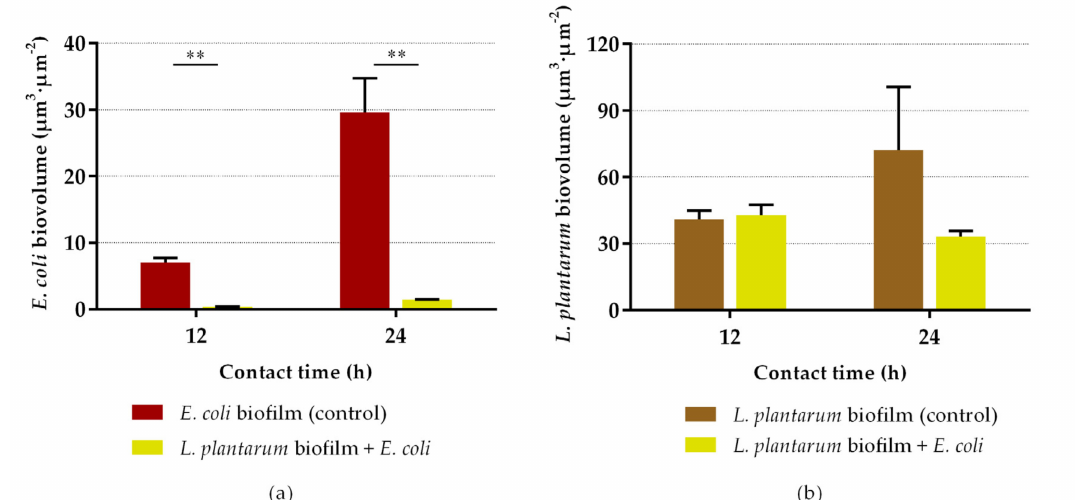
Figure 5. Biovolume of E. coli ( a ) and L. plantarum ( b ) after 12 and 24 h of contact between the pre-formed probiotic biofilm and the pathogen. This quantitative biofilm parameter was determined from confocal z -stacks using the plug-in COMSTAT2 associated with the ImageJ software. The data present the mean and standard deviation (SD) of at least five stacks of each sample. Statistically significant differences between the control and exposure were considered for p -values < 0.05 (** indicates p < 0.01).